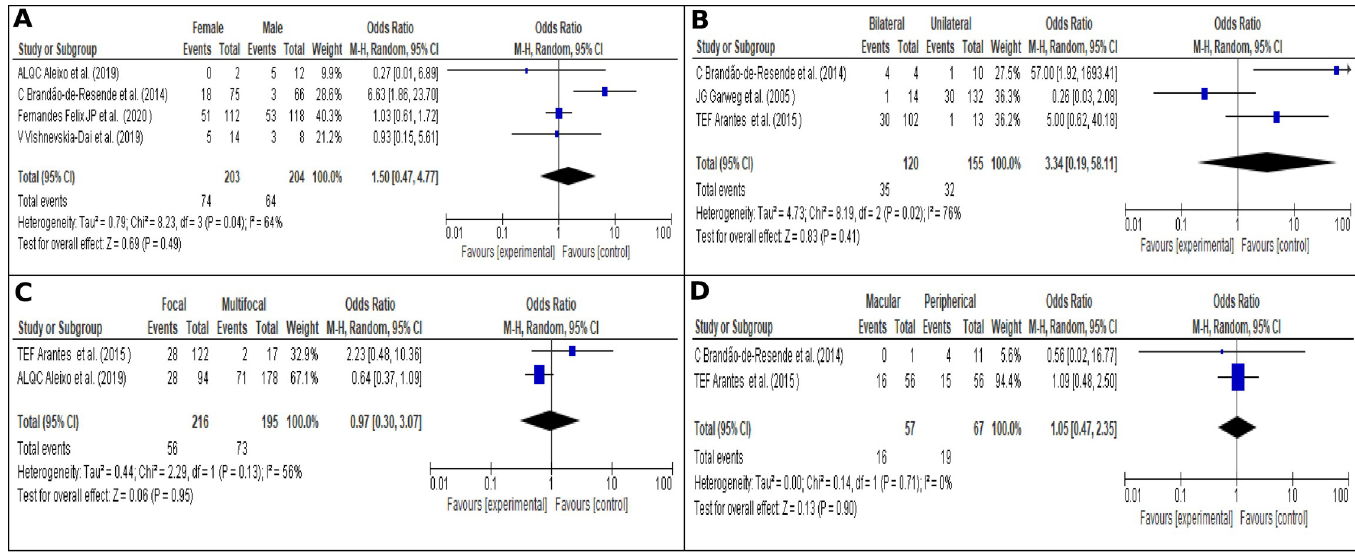
Fig 6. Recurrences related factors. (A). Laterality, (B). Localization; (C). Sex; (D). Number of lesions.